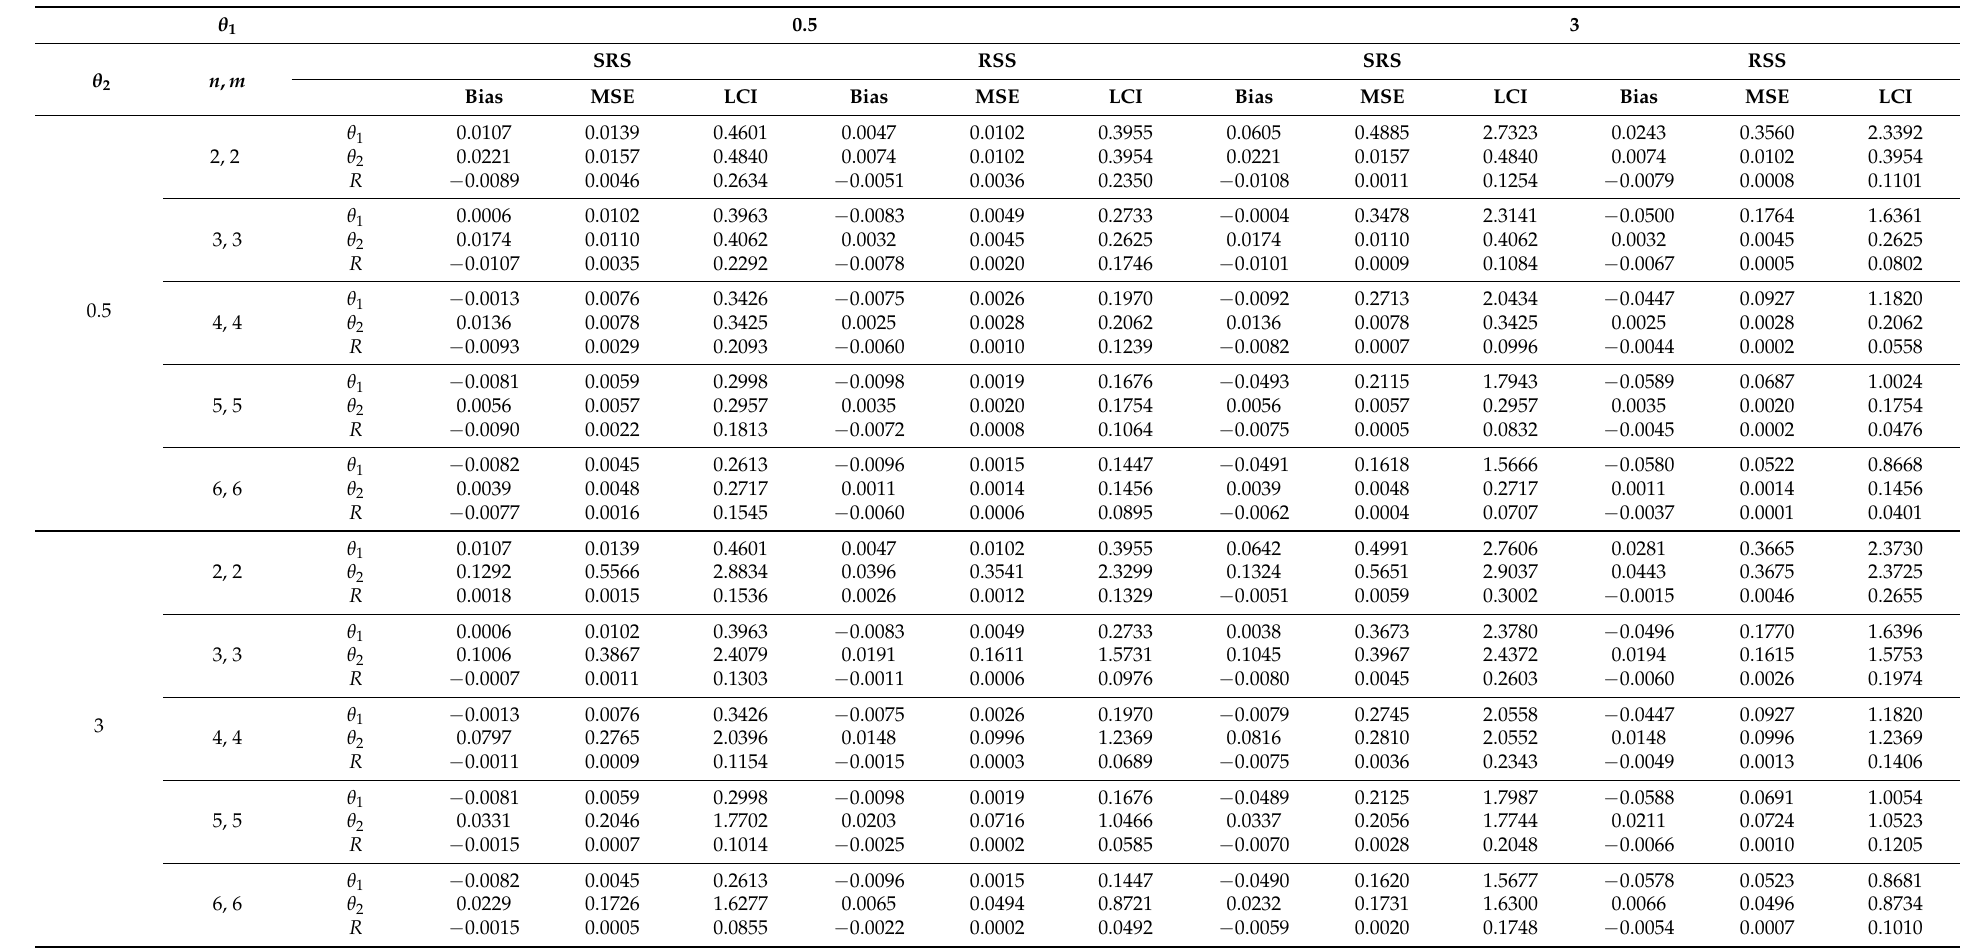
Table 1. SRS and RSS by ML Method of Parameter and R of ITL Stress Strength